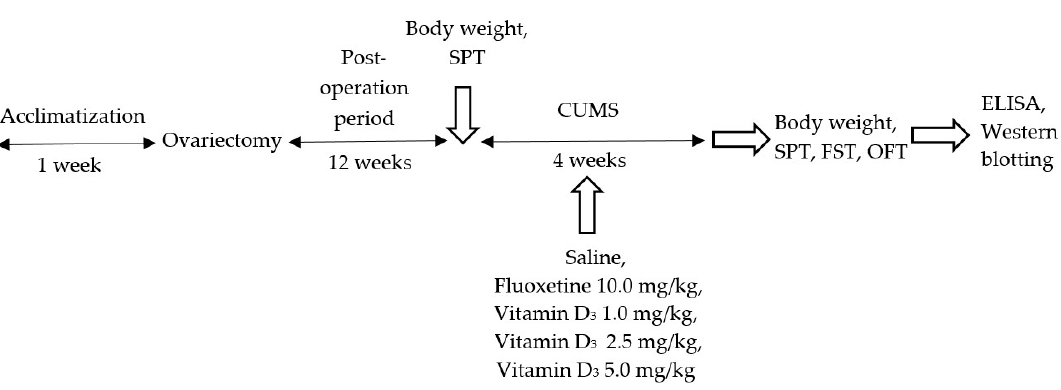
Figure 1. Total scheme of the present experimental study. The antidepressant-like effects of VD 3 at different doses (1.0, 2.5, and 5.0 mg/kg sc) on the model of depression produced by chronic unpredictable mild stress (CUMS) for 28 days in the long-term (3 months) OVX rats. Sucrose preference (SPT), forced swimming (FST), and open-field (OFT) tests were conducted to examine the depression-like state. Serum corticosterone/ACTH, 25-OH-VD 3 , estradiol levels and hippocampal BDNF, and NT-3/NT-4 expressions were determined by enzyme-linked immunosorbent assay (ELISA) kits and/or western blotting to assess the possible mechanisms of the VD 3 effects on the depression-like profile in long-term OVX rats subjected to CUMS.